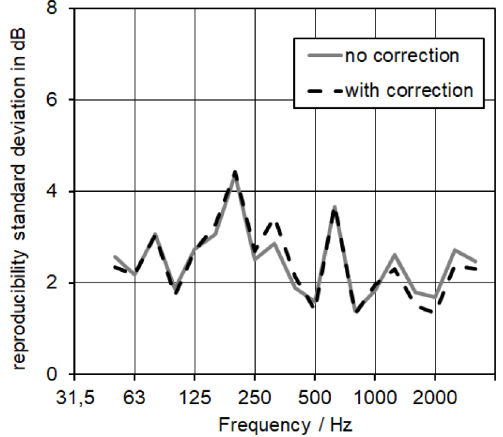
Figure 15. Reproducibility standard deviation of the single equivalent blocked force